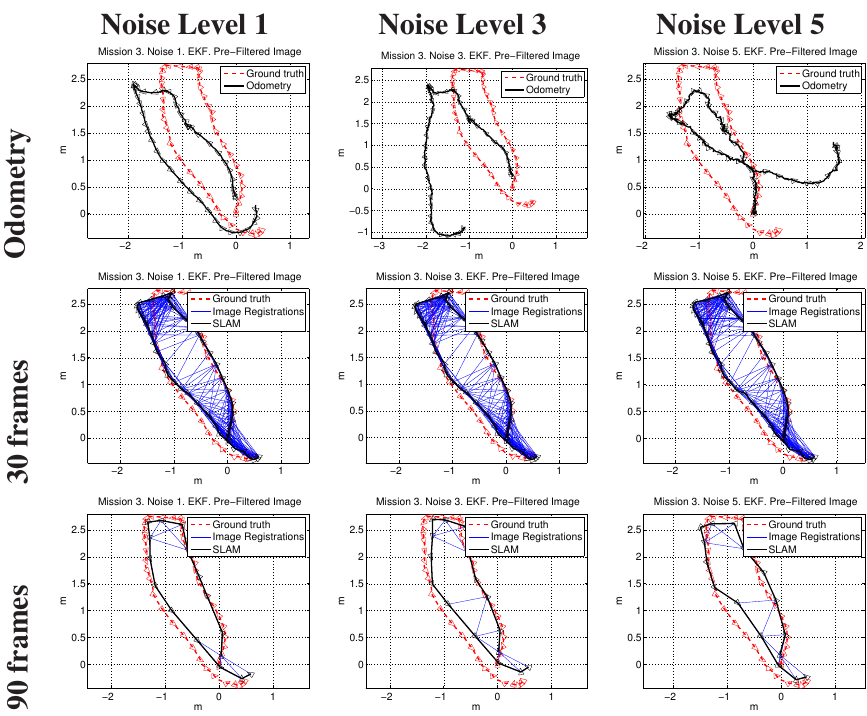
Figure 16. Example results corresponding to the third mission. The first row compares visual odometry and ground truth. The next rows correspond to different keyframe separations. The first, second and third columns are related to Noise Levels 1, 3 and 5,